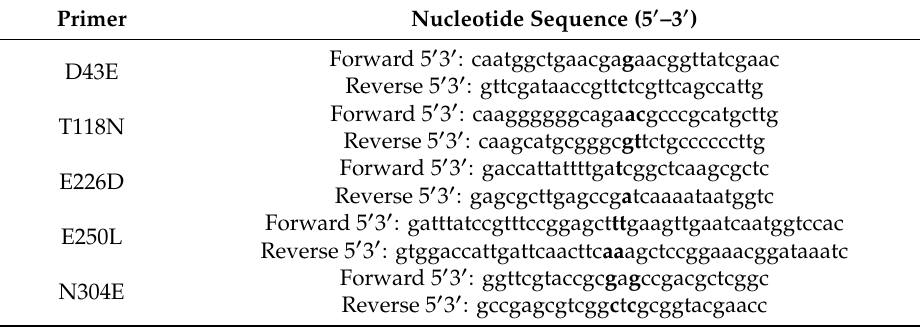
Table 6. Mutagenic primers for the construction of HT1 mutants. The sequence in bold is the mutated